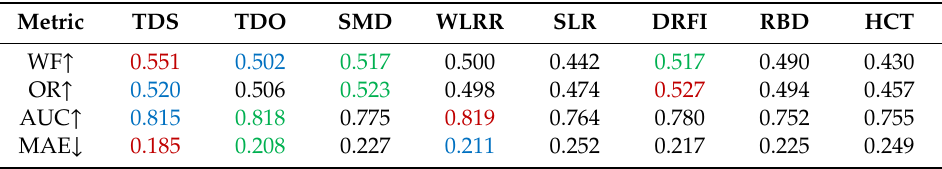
Table 2. Result on extended complex scene saliency dataset (ECSSD) dataset in terms of WF, MAE, OR, and